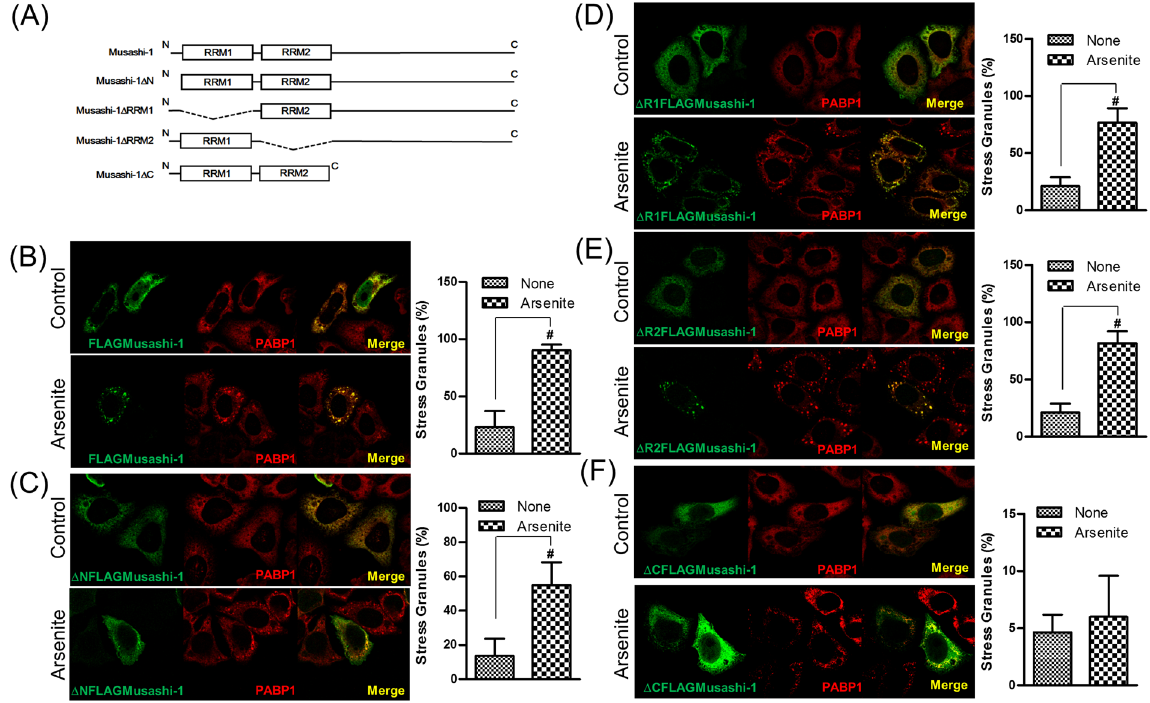
Figure 5. The Musashi-1 C-terminal domain is required for granule formation. HCT-116 cells were transfected with various Musashi-1 domain swap constructs. Forty-eight hours after transfections, cells were stimulated with arsenite (150 μ M) for 30 min. Cells were then fixed in 4% paraformaldehyde at room temperature and subjected to immunostaining. ( A ) Schematic diagram of Musashi-1 domain swap constructs. ( B ) Left panel: Co-localization of FLAGMusashi-1 and PABP1. Right panel: Statistical results of percentages of SG formation. Error bars indicate the mean ± SD from three independent experiments. # p < 0.05. ( C ) Left panel: Co- localization of Δ NFLAGMusashi-1 and PABP1. Right panel: Statistical results of percentages of SG formation. Error bars indicate the mean ± SD from three independent experiments. # p < 0.05. ( D ) Left panel: Co- localization of Δ R1FLAGMusashi-1 and PABP1. ( E ) Left panel: Co-localization of Δ R2FLAGMusashi-1 and PABP1. Right panel: Statistical results of percentages of SG formation. Error bars indicate the mean ± SD from three independent experiments. # p < 0.05. ( F ) Left panel: Co-localization of Δ CFLAGMusashi-1 and PABP1. Right panel: Statistical results of percentages of SG formation. Error bars indicate the mean ± SD from three independent